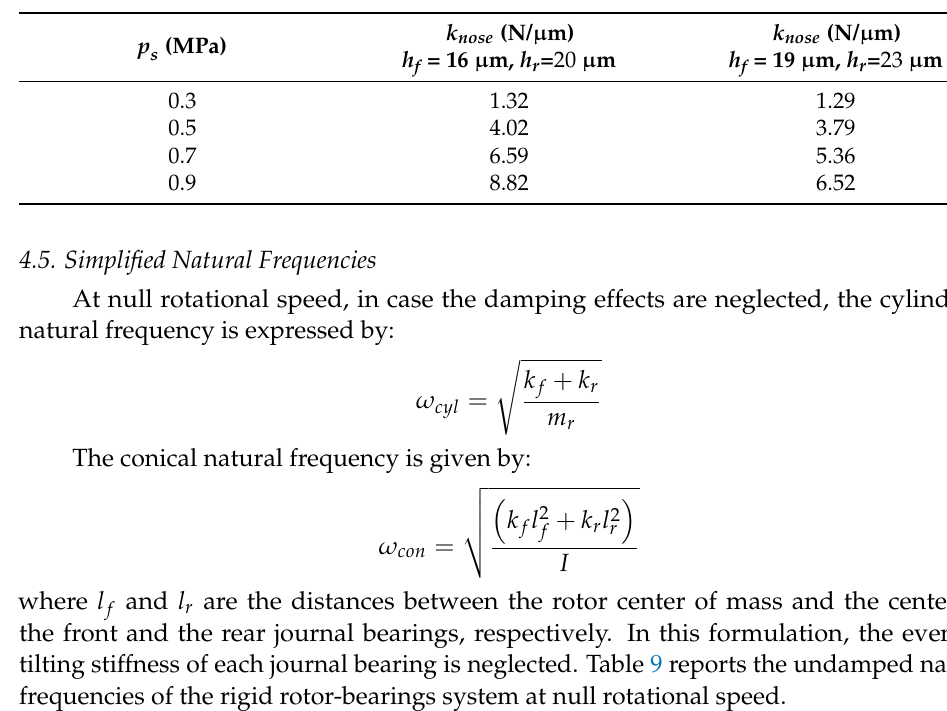
Table 8. Radial stiffness of the nose at different supply pressures and radial clearances; these values were obtained with a 30 N load applied on the